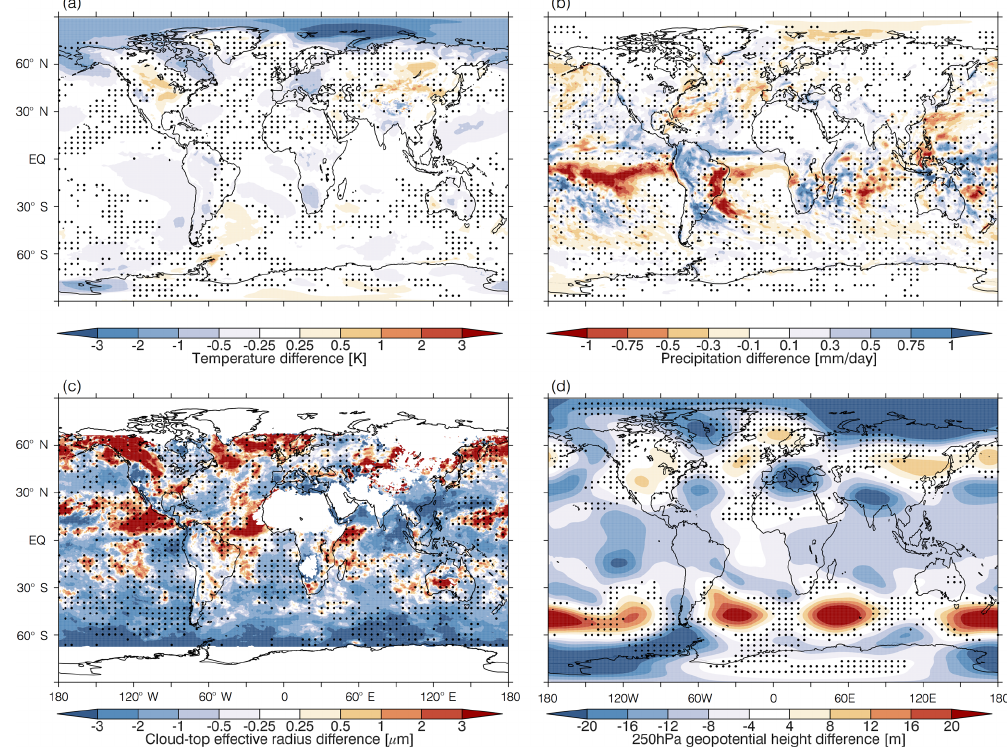
Figure 6. Ensemble mean, (1998–2012) vs. (1979–1993), difference in (a) near-surface temperature, (b) precipitation, (c) cloud-top effective radius, and (d) 250hPa geopotential height. In regions without stippling, the anomaly has the same sign in three or more ensemble members.